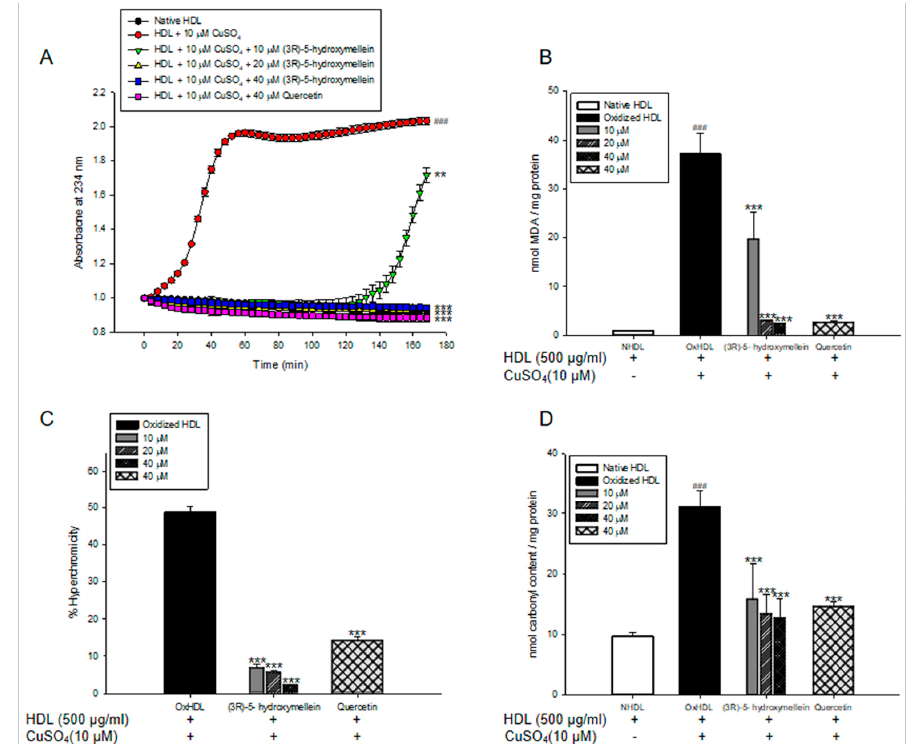
Figure 2. Effect of (3 R )-5-hydroxymellein on Cu 2+ -induced high-density lipoprotein (HDL) oxidation. ( A ) Continuous monitoring of the conjugated diene levels by absorbance at 234 nm (A 234 ) during 10 µ M of copper-ion-mediated HDL oxidation in the presence of (3 R )-5-hydroxymellein. ( B ) Effects of (3 R )-5-hydroxymellein (at 10, 20, and 40 µ M) in TBARS production during HDL oxidation induced by CuSO 4 for 4 h at 37 ◦ C. (C) Percent of hyperchromicity (absorbance at 280 nm) of oxHDL, and HDL treated with (3 R )-5-hydroxymellein (at 10, 20, and 40 μ M). (D) Carbonyl content determination of native HDL, oxHDL, and HDL treated with (3 R )-5-hydroxymellein (at 10, 20, and 40 μ M). Quercetin used as a positive control. These data are expressed as mean ± SD of three independent experiments. ### p < 0.001 vs. NHDL (native HDL); *** p < 0.001 vs. oxHDL (oxidized LDL).